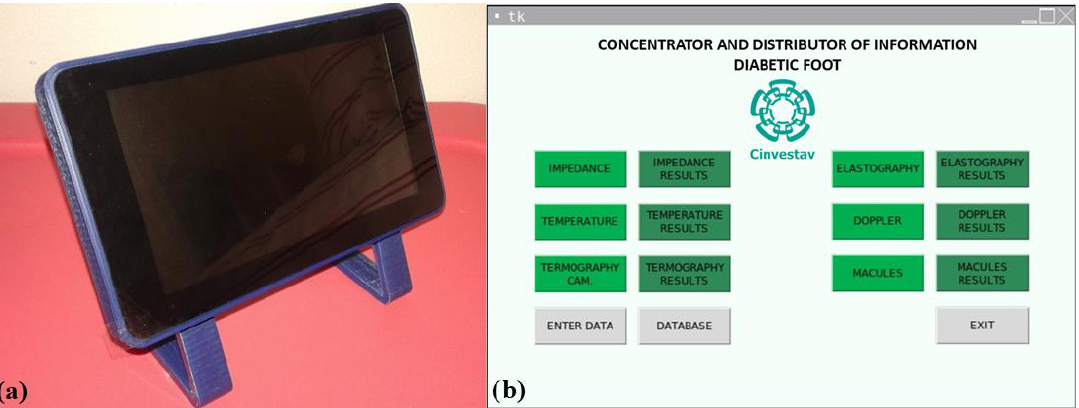
Figure 12. ( a ) Image of the portable diabetic foot information hub system; ( b ) screenshot of the in- terface for system control, acquisition of measurements, creation of the file, access to database, etc.